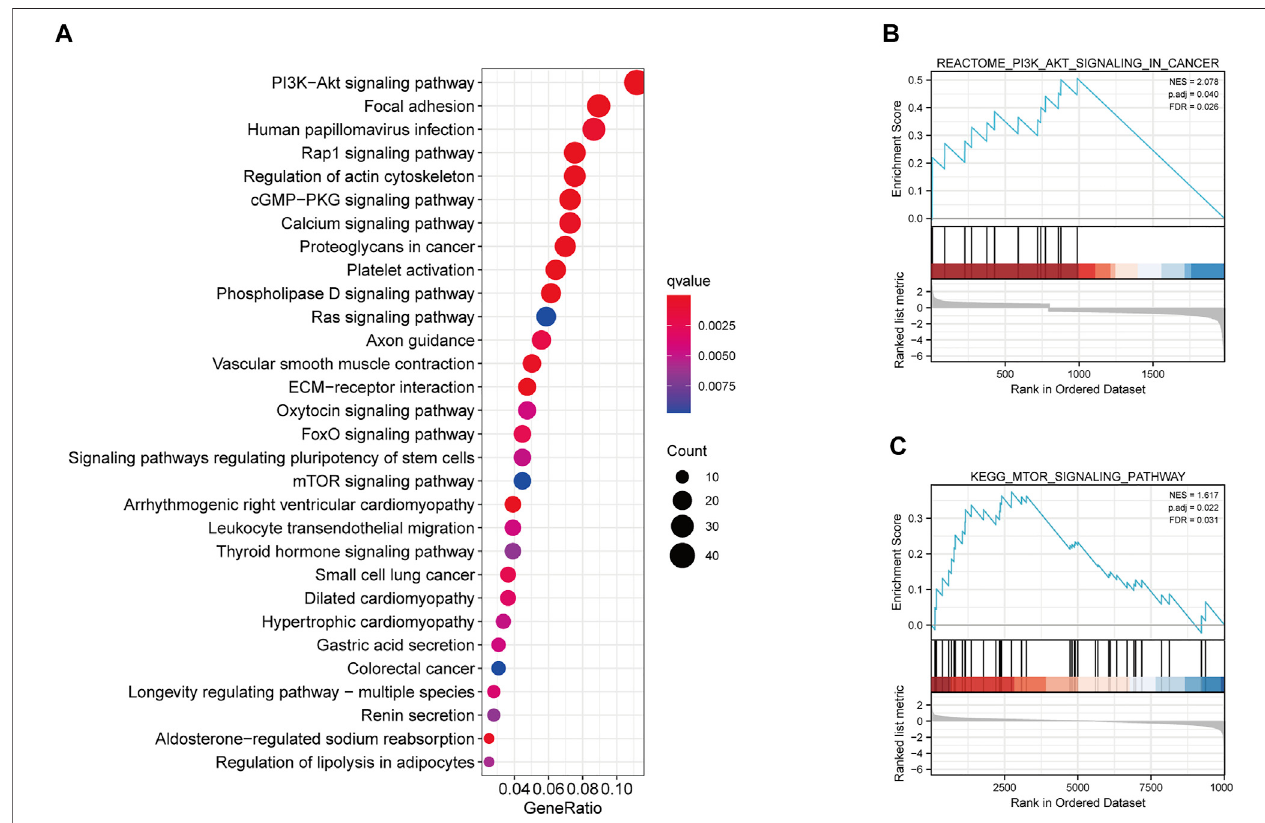
FIGURE 6 | KEGG and GSEA analysis of MRGPS. (A) KEGG analysis of the DEGs between high- and low-risk groups. (B) PI3K − Akt signaling pathway and (C) mTOR signaling pathway were identi fi ed in the high-risk group.